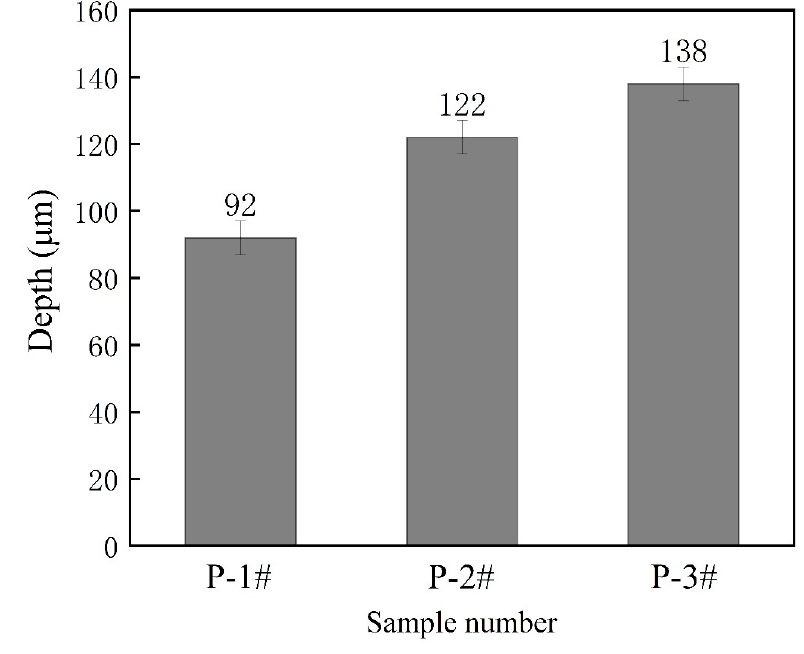
Figure 4. Depth of modified layer by LSR.